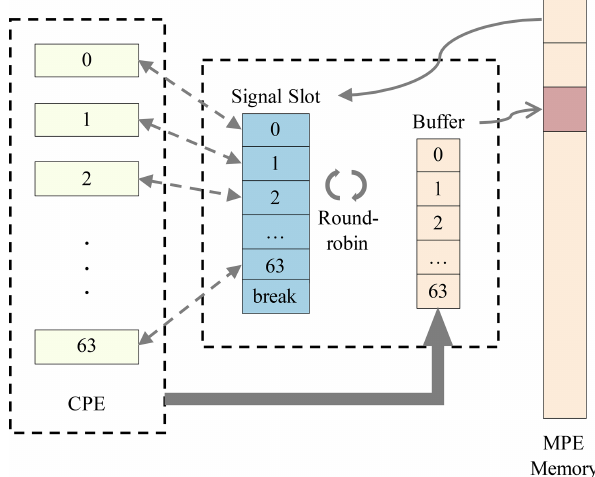
Figure 5. Time-division refresh technology for